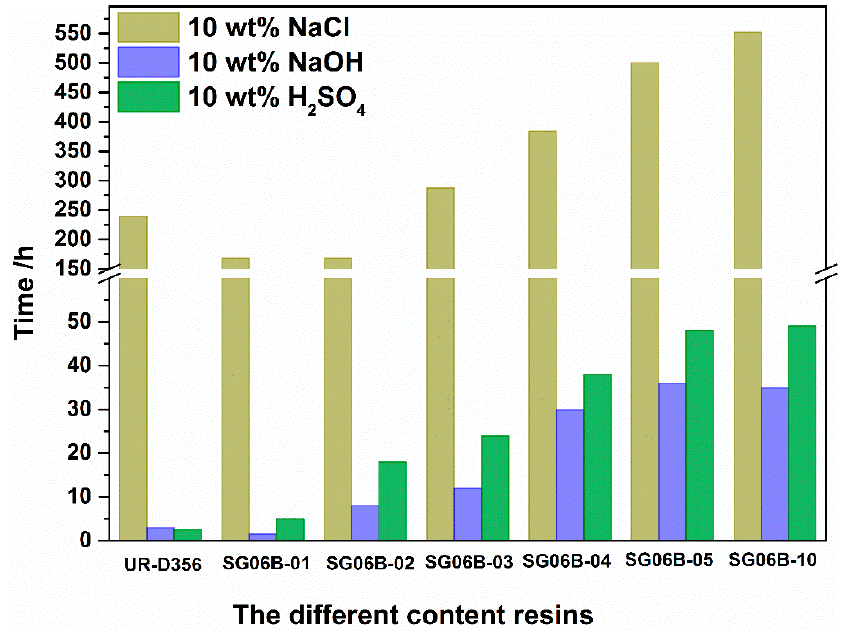
Figure 13. The bubble time with different contents of SG06B series polymers after being dipped in salt, alkaline, and acid solution.